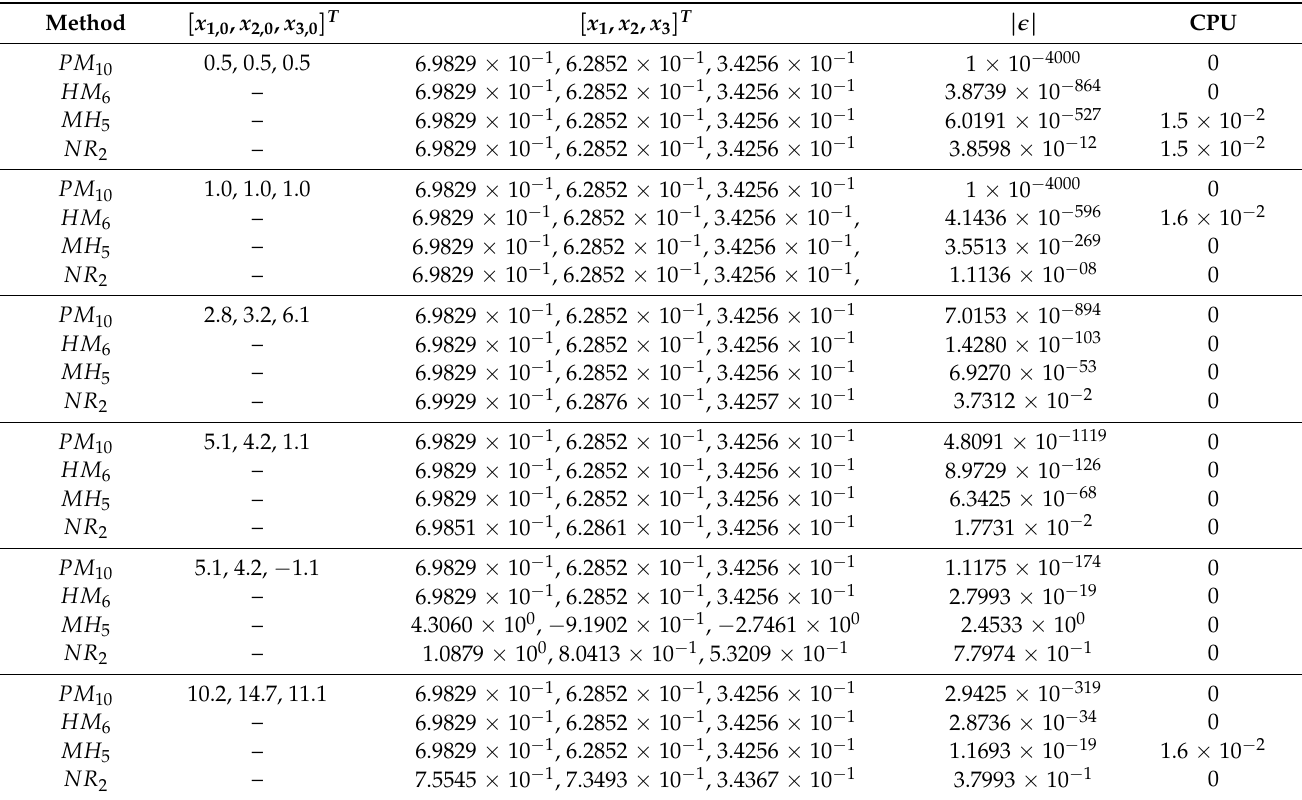
Table 14. Numerical results for problem